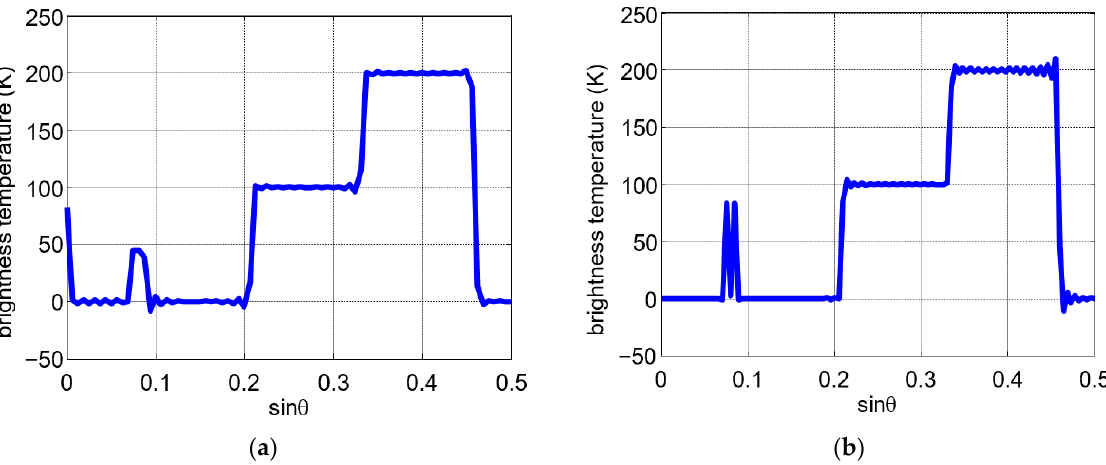
Figure 5. Simulation results for different 1-D arrays. ( a ) 1-D MRA. ( b ) 1-D DPA.